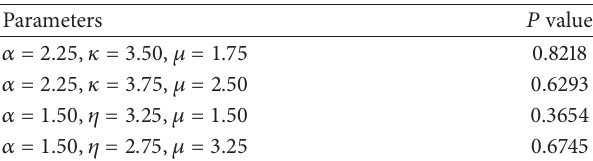
Table 1: 𝑃 values of the KS